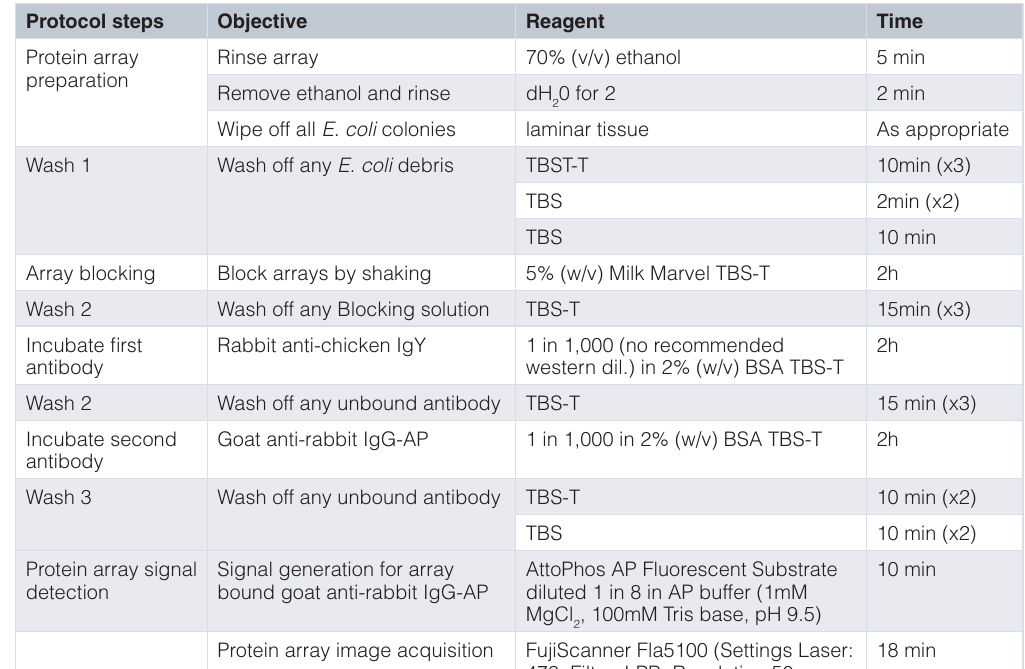
Table 3. Secondary antibody protein array analysis